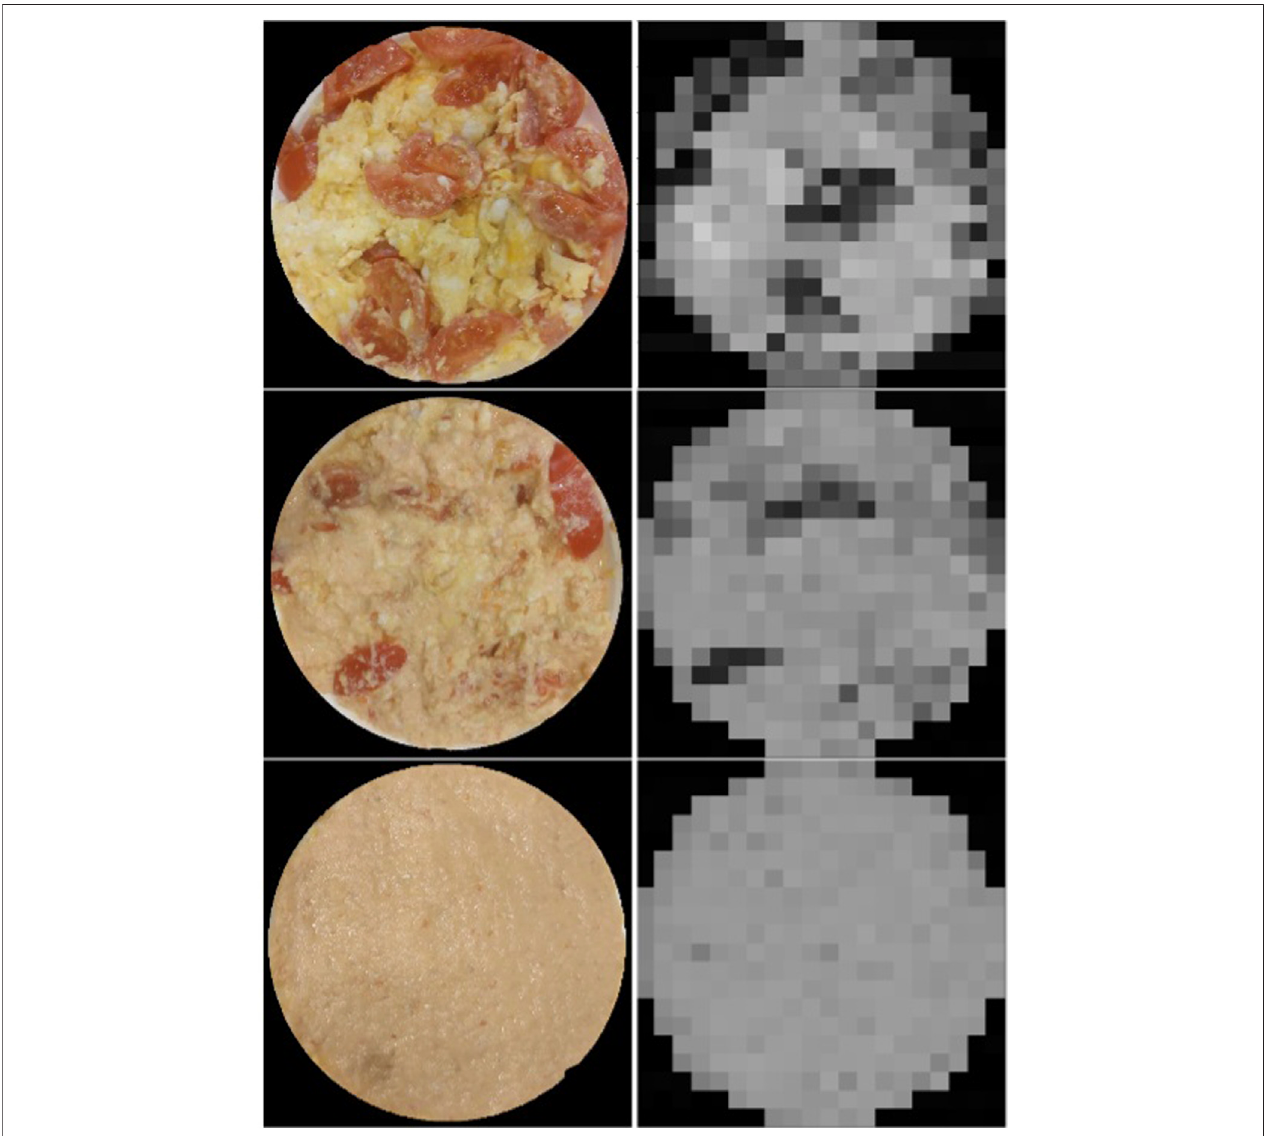
FIGURE 6 | Figure showing the taste mapping of the same tomato scramble after mixing it to three different stages, with unmixed and “ visually homogeneous ” being the extreme cases.